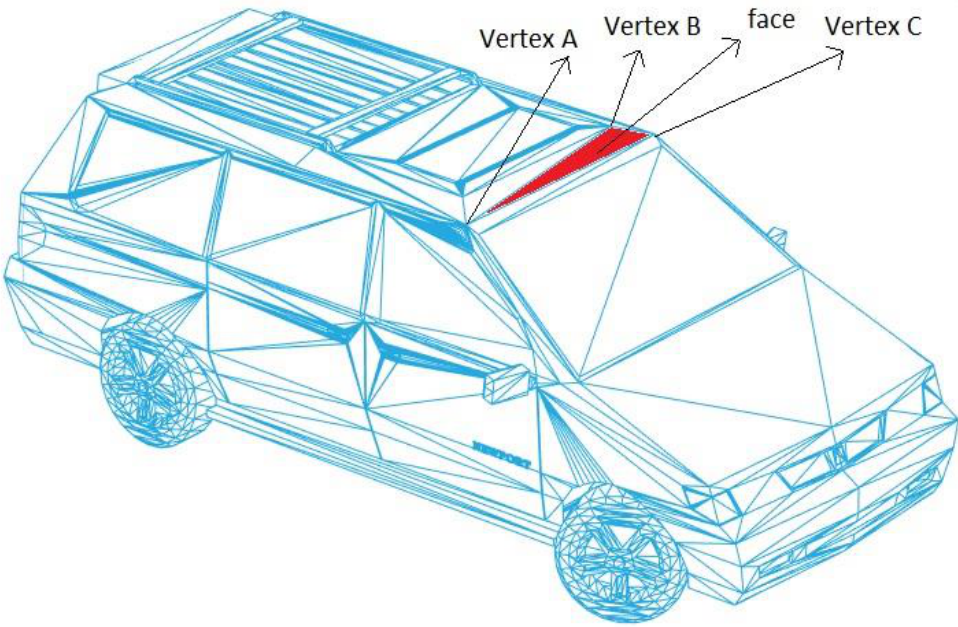
Figure 3. A total of 41,285 vertices of one 3D shape.